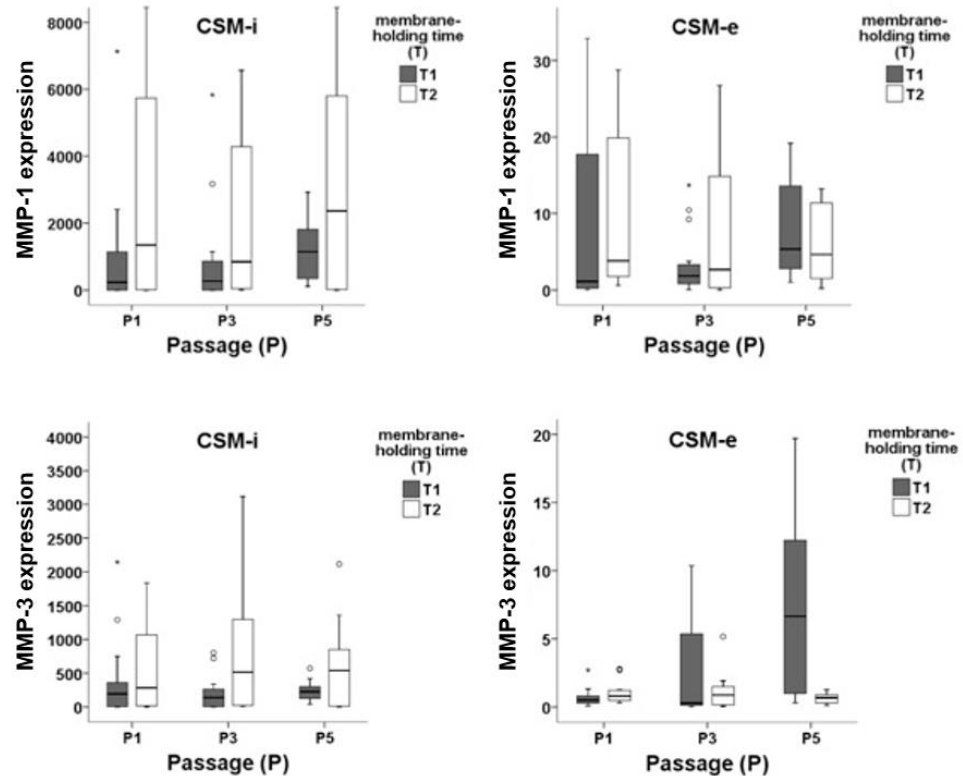
Figure 3. mRNA expression patterns of MMP-1 and MMP-3 within in vitro (CSM-i) and in vivo (CSM-e) membranes subdivided by cell passage 1 (P1), 3 (P3), and 5 (P5) and membrane-holding time 5 h (T1) and two weeks (T2). Outliers are marked separately with *.